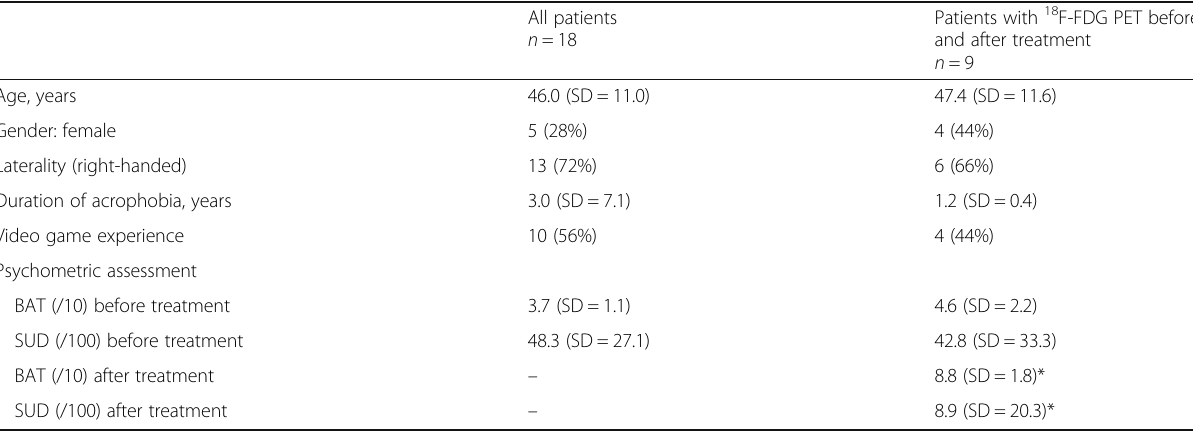
Table 1 Characteristics of the patients